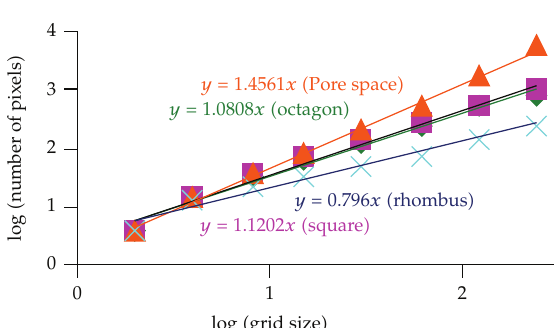
Figure 7: Graphical plots between log (cid:2) number of pixels of pore connectivity network in Figure 6 (cid:2) a (cid:3) –6 (cid:2) c (cid:3) by structuring elements (cid:2)(cid:2) i (cid:3) octagon, (cid:2) ii (cid:3) square or pore space (cid:3) versus log (cid:2) step sizes (cid:3) from the first to the tenth iterations of opening